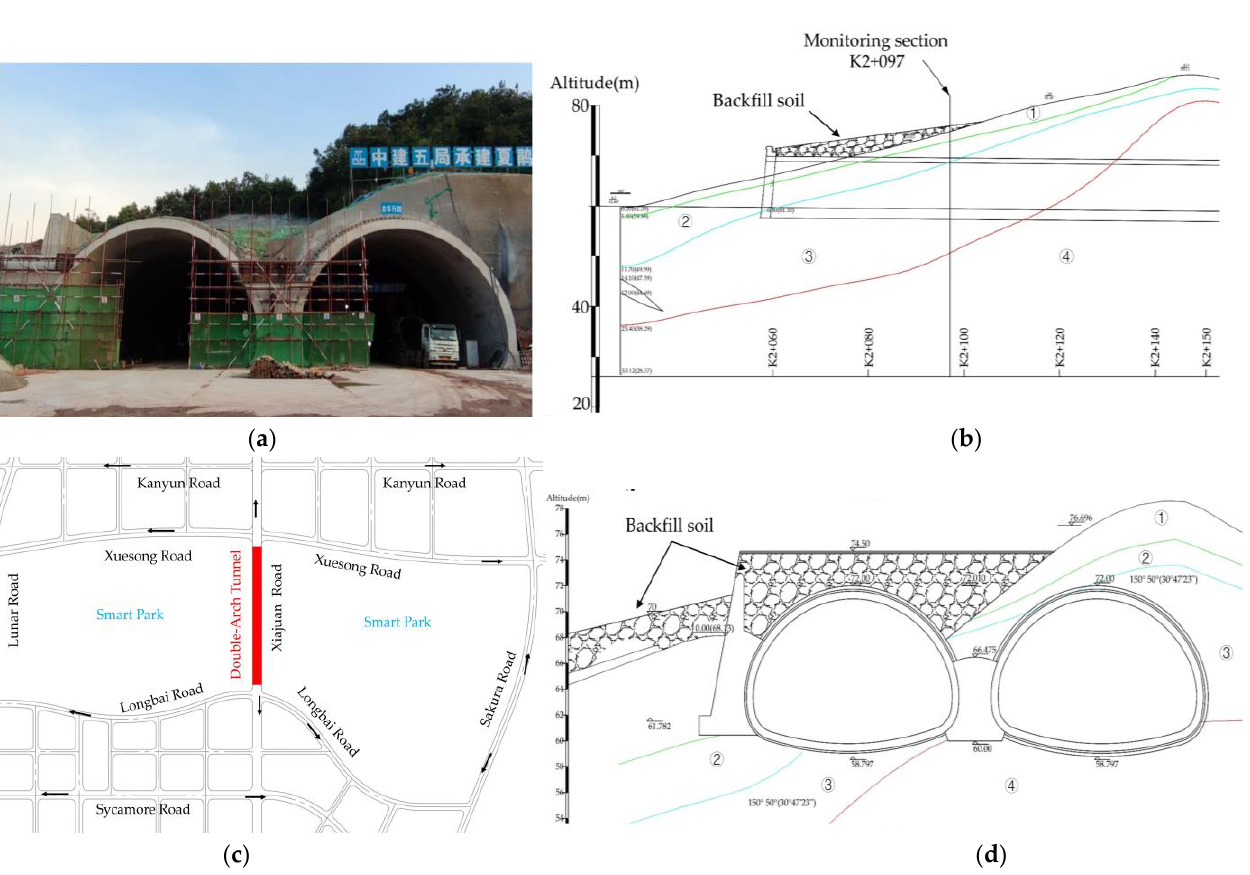
Figure 1. Location and longitudinal and cross profiles of the double-arch tunnel on Xiajuan Road. ( a ) Front view of tunnel; ( b ) Longitudinal geological profile; ( c ) Project location map; ( d ) Monitoring section K2+097.